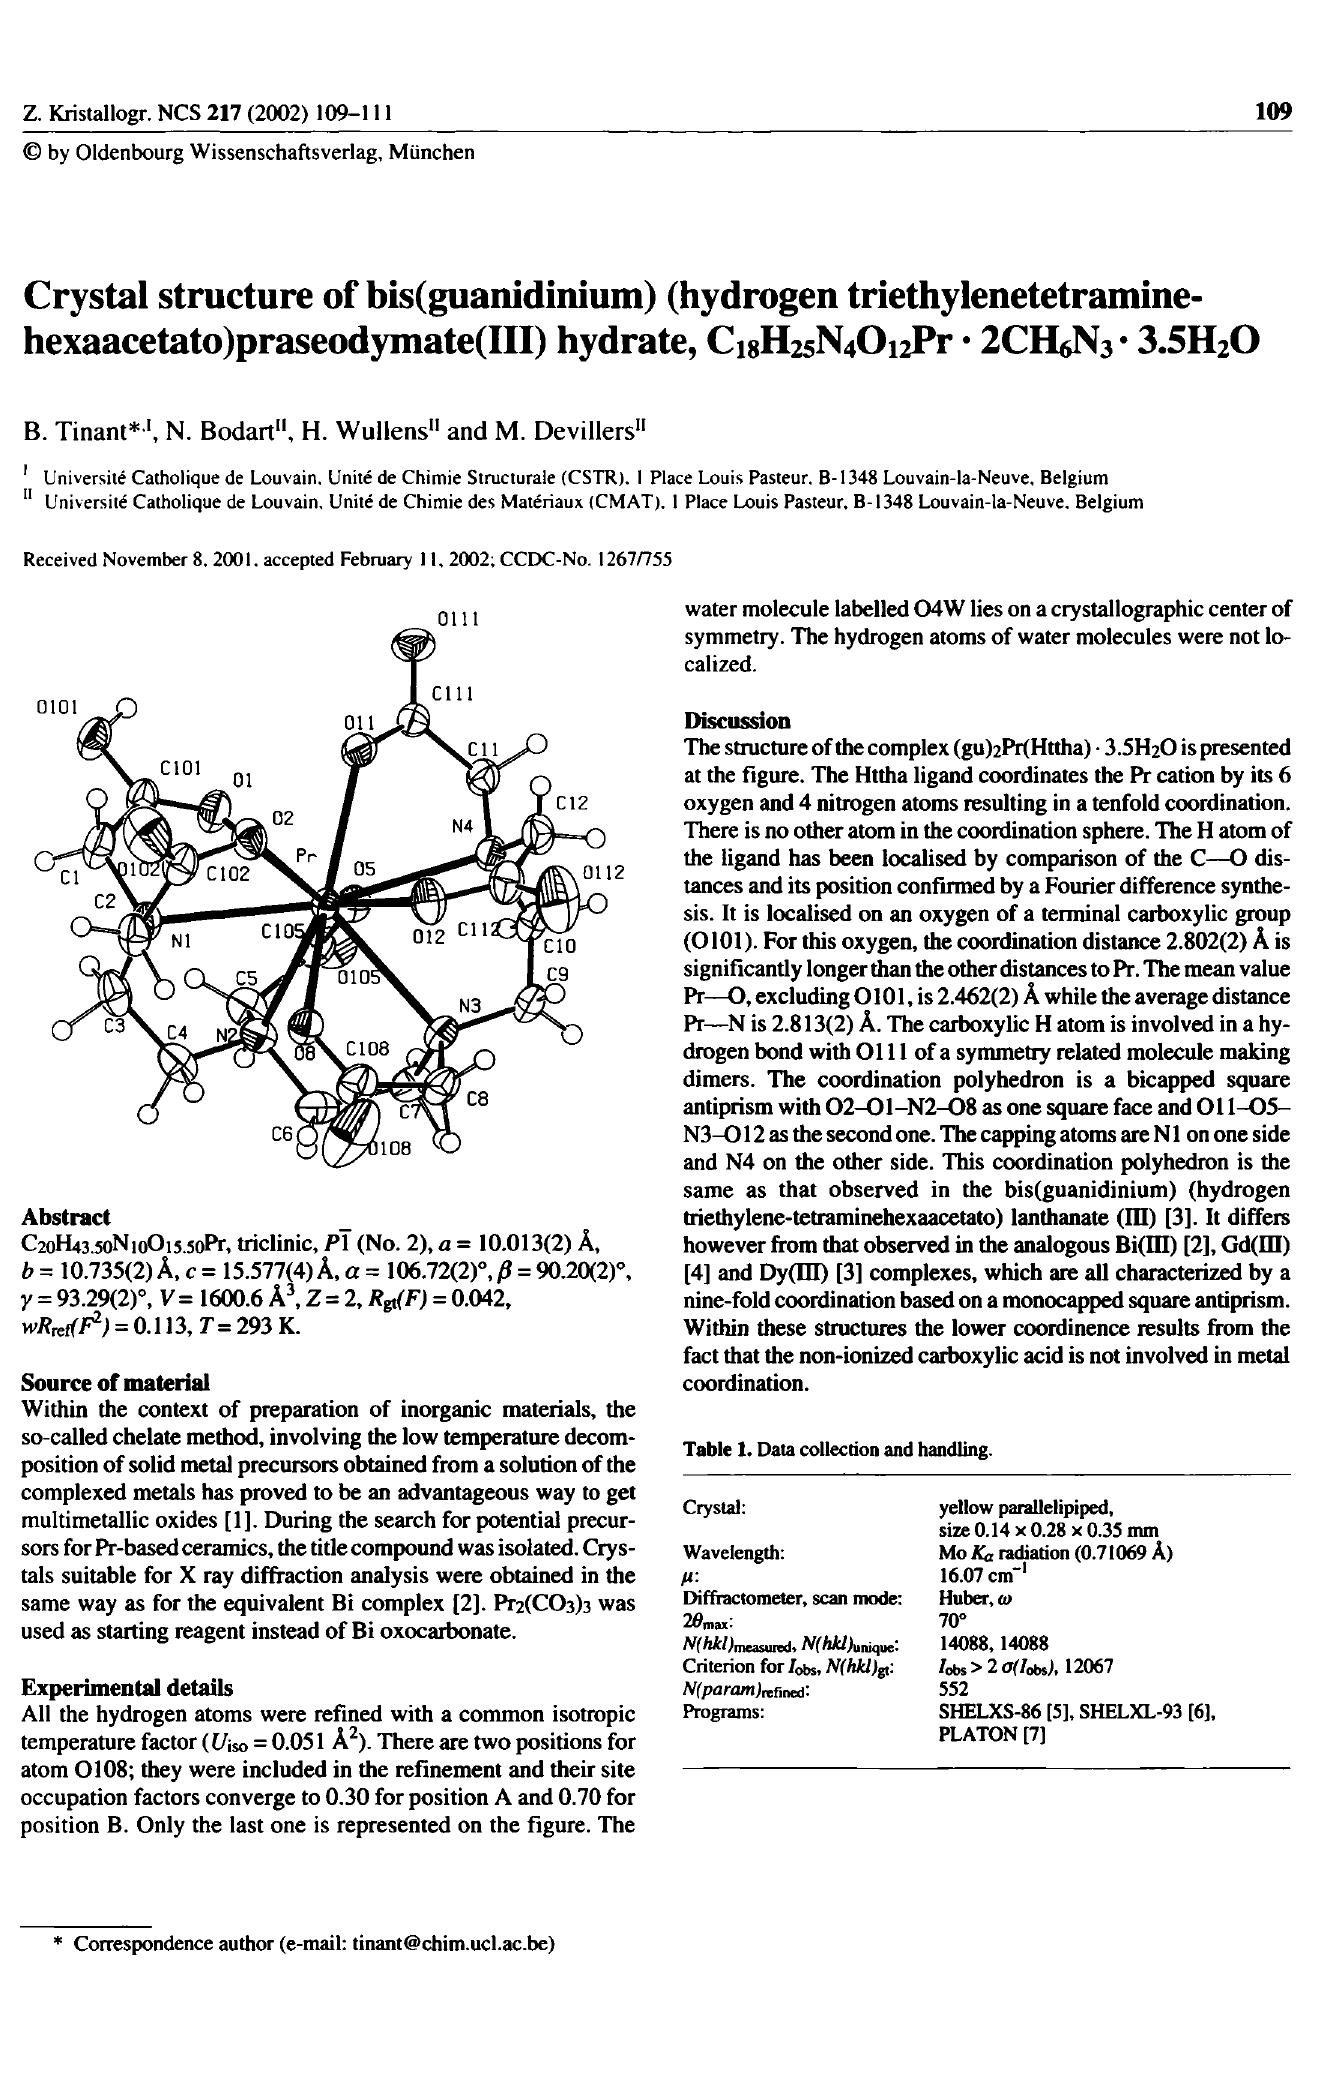
Table 1. Data collection and